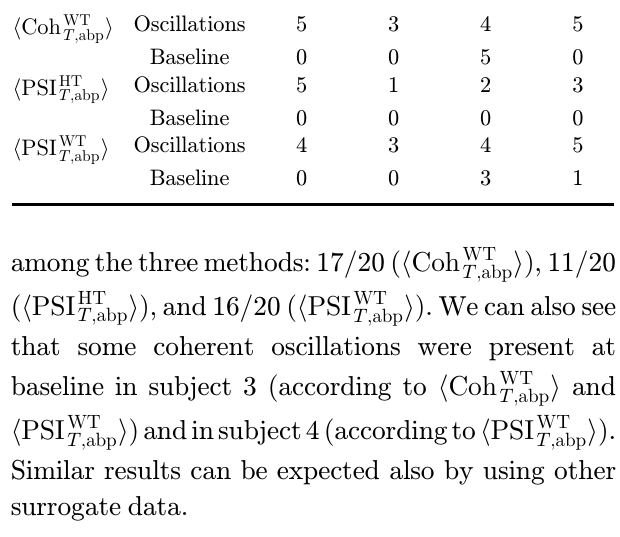
Table 2. Number of frequencies (out of the ¯ve considered frequencies of 0.045, 0.056, 0.0625, 0.071, and 0.023 Hz) that feature signi¯cant coherence or phase synchronization during cyclic thigh cu® occlusions and at baseline, for the three non- stationary metrics and thresholds obtained with the surrogate data method